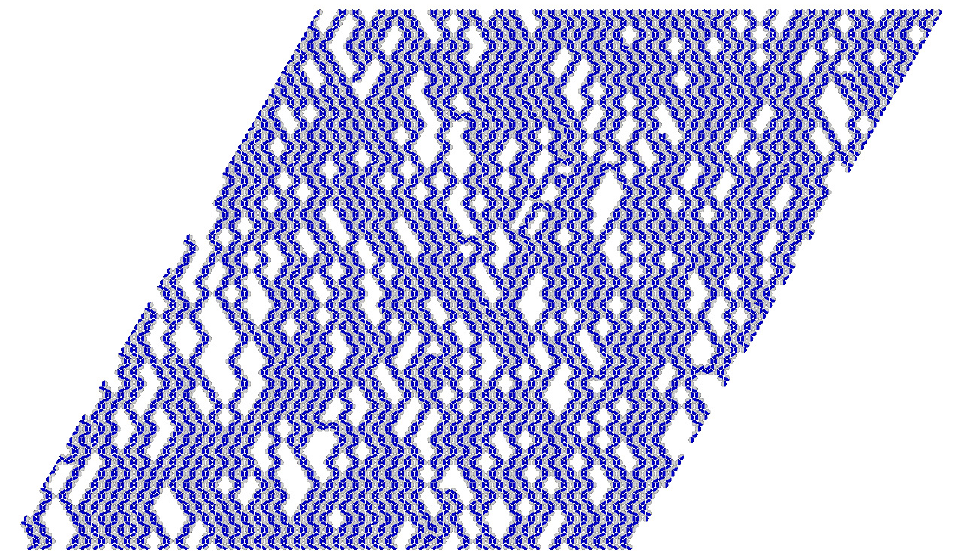
Figure 11. The snapshot recorded for the system with u ∗ = − 0.01, at T = 0.08 and µ = − 1.126, which shows the structure of the phase Z 2